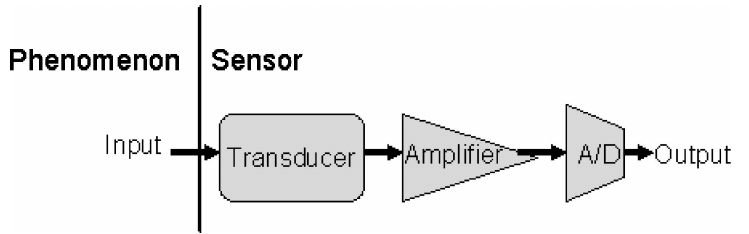
Figure 1. Depiction of a sensor and its key components.